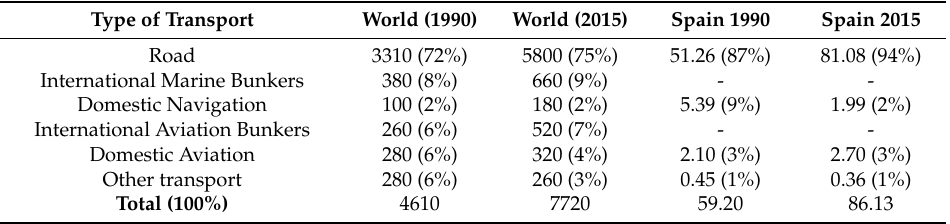
Table 1. CO 2 emissions by transport sector (MtCO 2 )